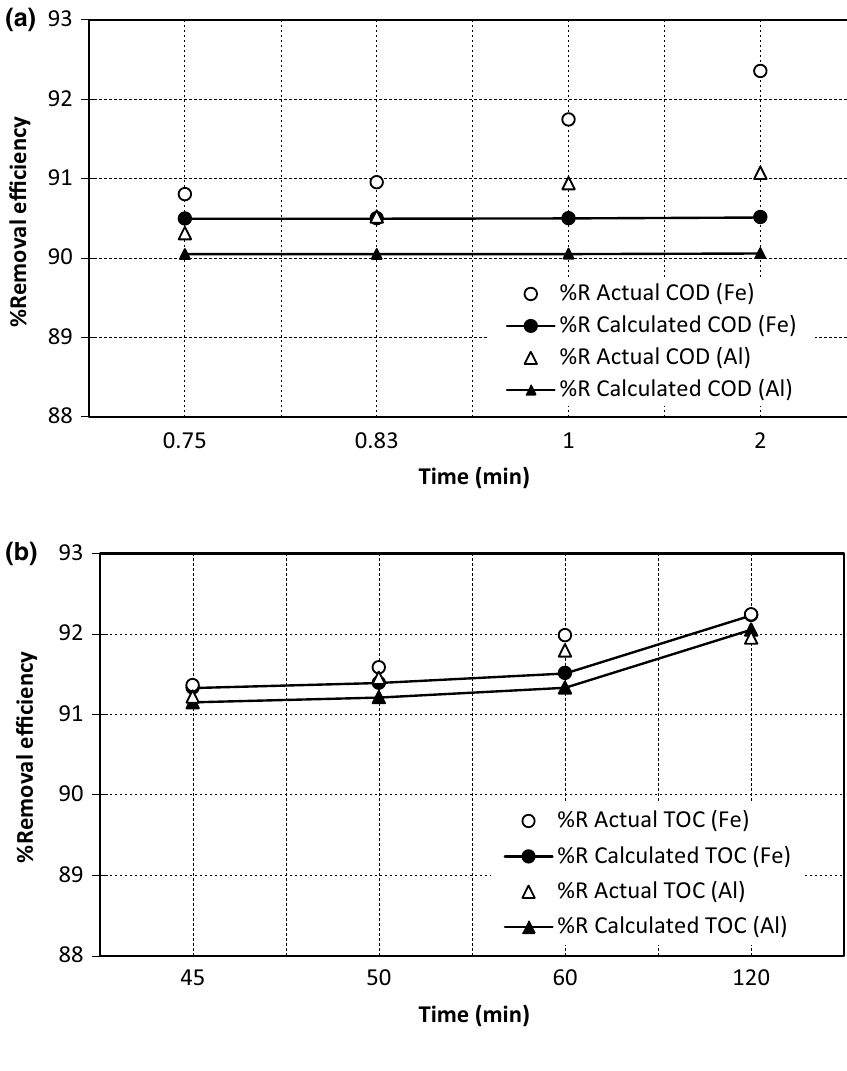
Fig. 7 The effect of electrolysis time on the COD and TOC removal for multiple regression analysis ( i = 0.3226 mA/cm 2 ; C o,COD = 399,800 mg/L; = 98,120 mg/L 1 ; NaCl = 1 g/L 1 ; pH 6; T = 298 K;